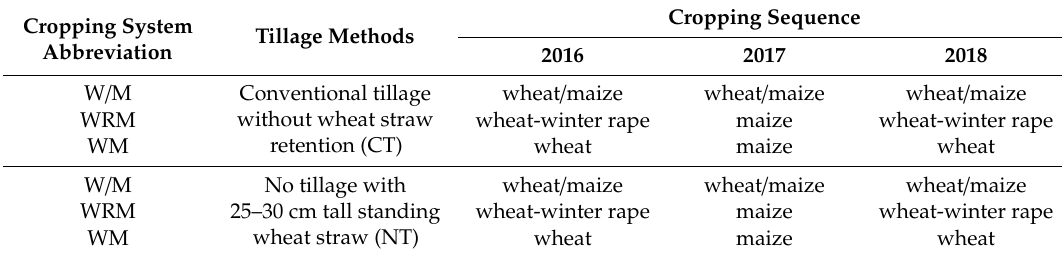
Table 1. Description of cropping system and tillage method